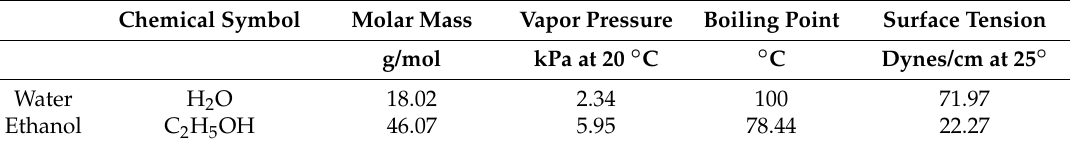
Table 1. Comparison of physical properties of water vs. ethanol